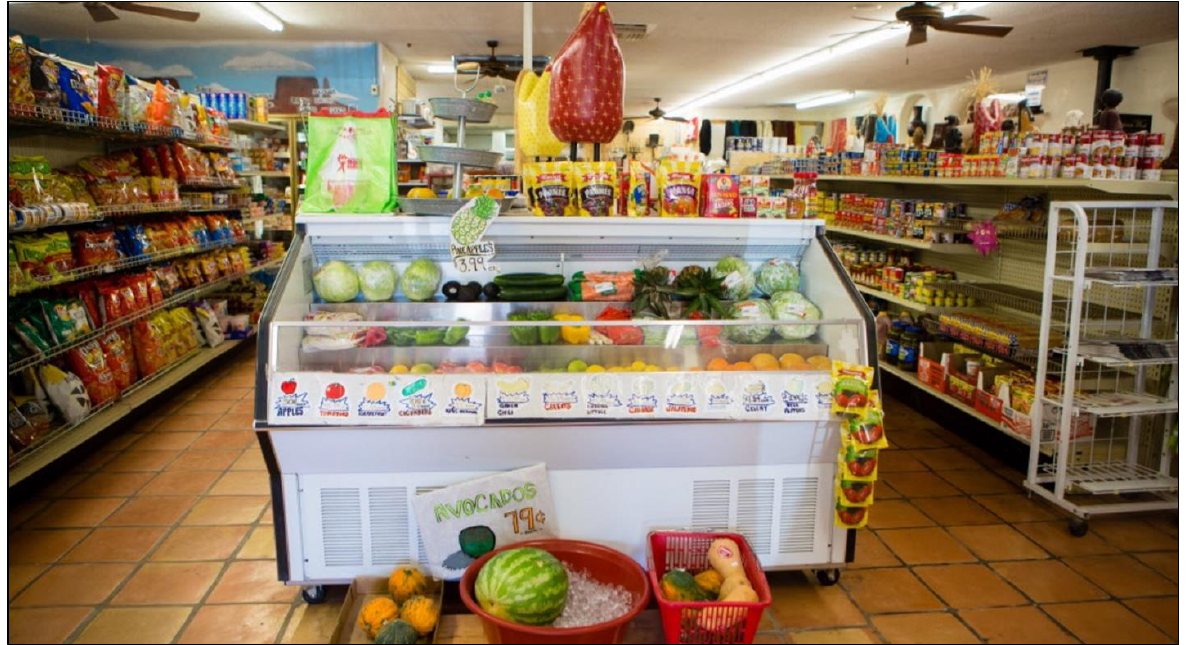
Figure 4. Produce Display with Signage at Teec Nos Pos Trading Post on Navajo